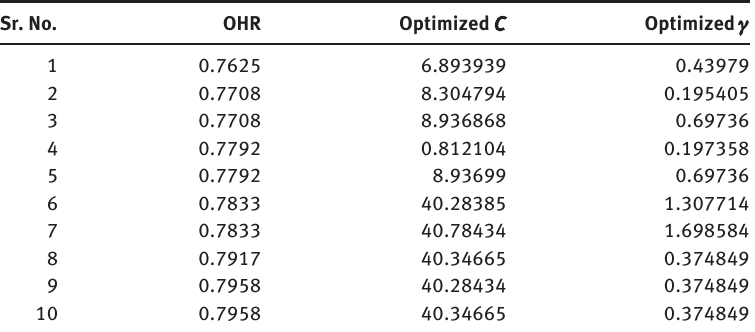
Table 3. Optimized Parameters for the German Data Set Using the MOGA-Based Approach. Sr. No.